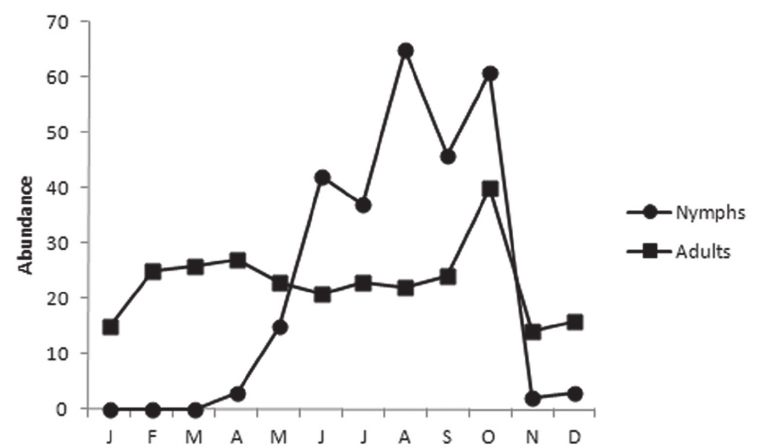
Figure 8. Phenology of Nezara viridula (Linnaeus, 1758) between December 2008 and November 2012, according to data from 550 pictures hosted in Biodiversidad Virtual internet photsharing